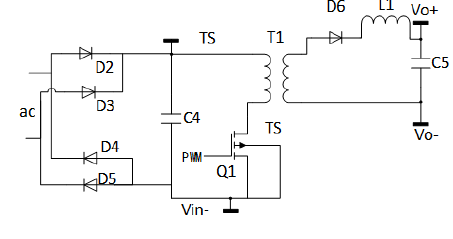
Fig. 1. Schematic diagram of switching power supply with flyback